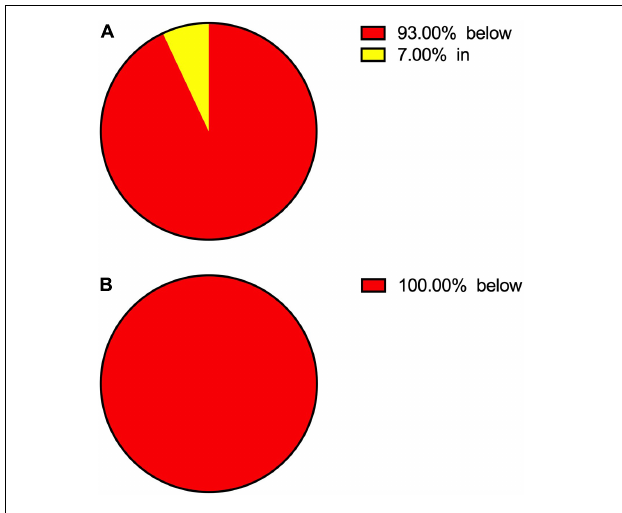
FIGURE 1 | Patients’ vitamin D status in: (A) SARS-CoV-2 (–) group; (B) SARS-CoV-2 (+) group. TABLE 3 | Correlations between features and SARS-CoV-2